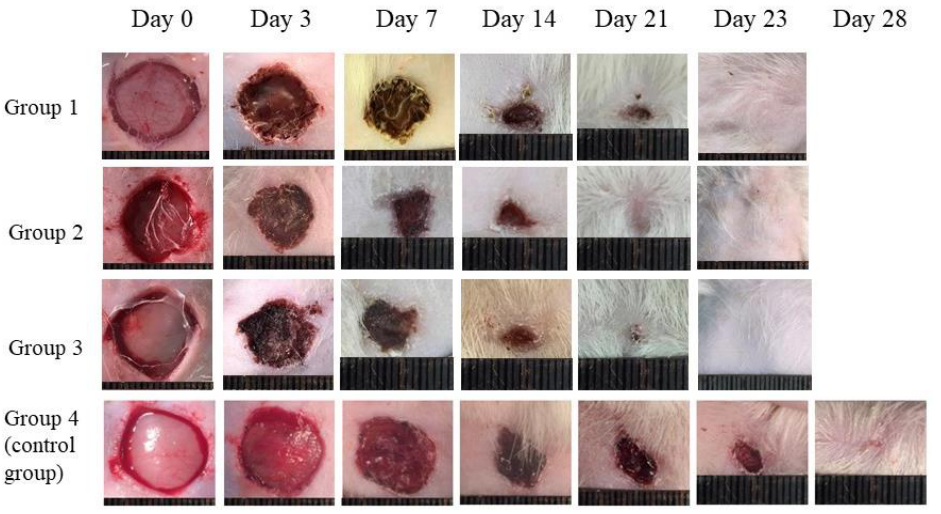
Figure 6. Images of wounds on the 0th, 3rd, 7th, 14th, 21st, 23rd and 28th days. Group 1: SF-F, group 2: SF-MS, and group 3: SFG-MS.